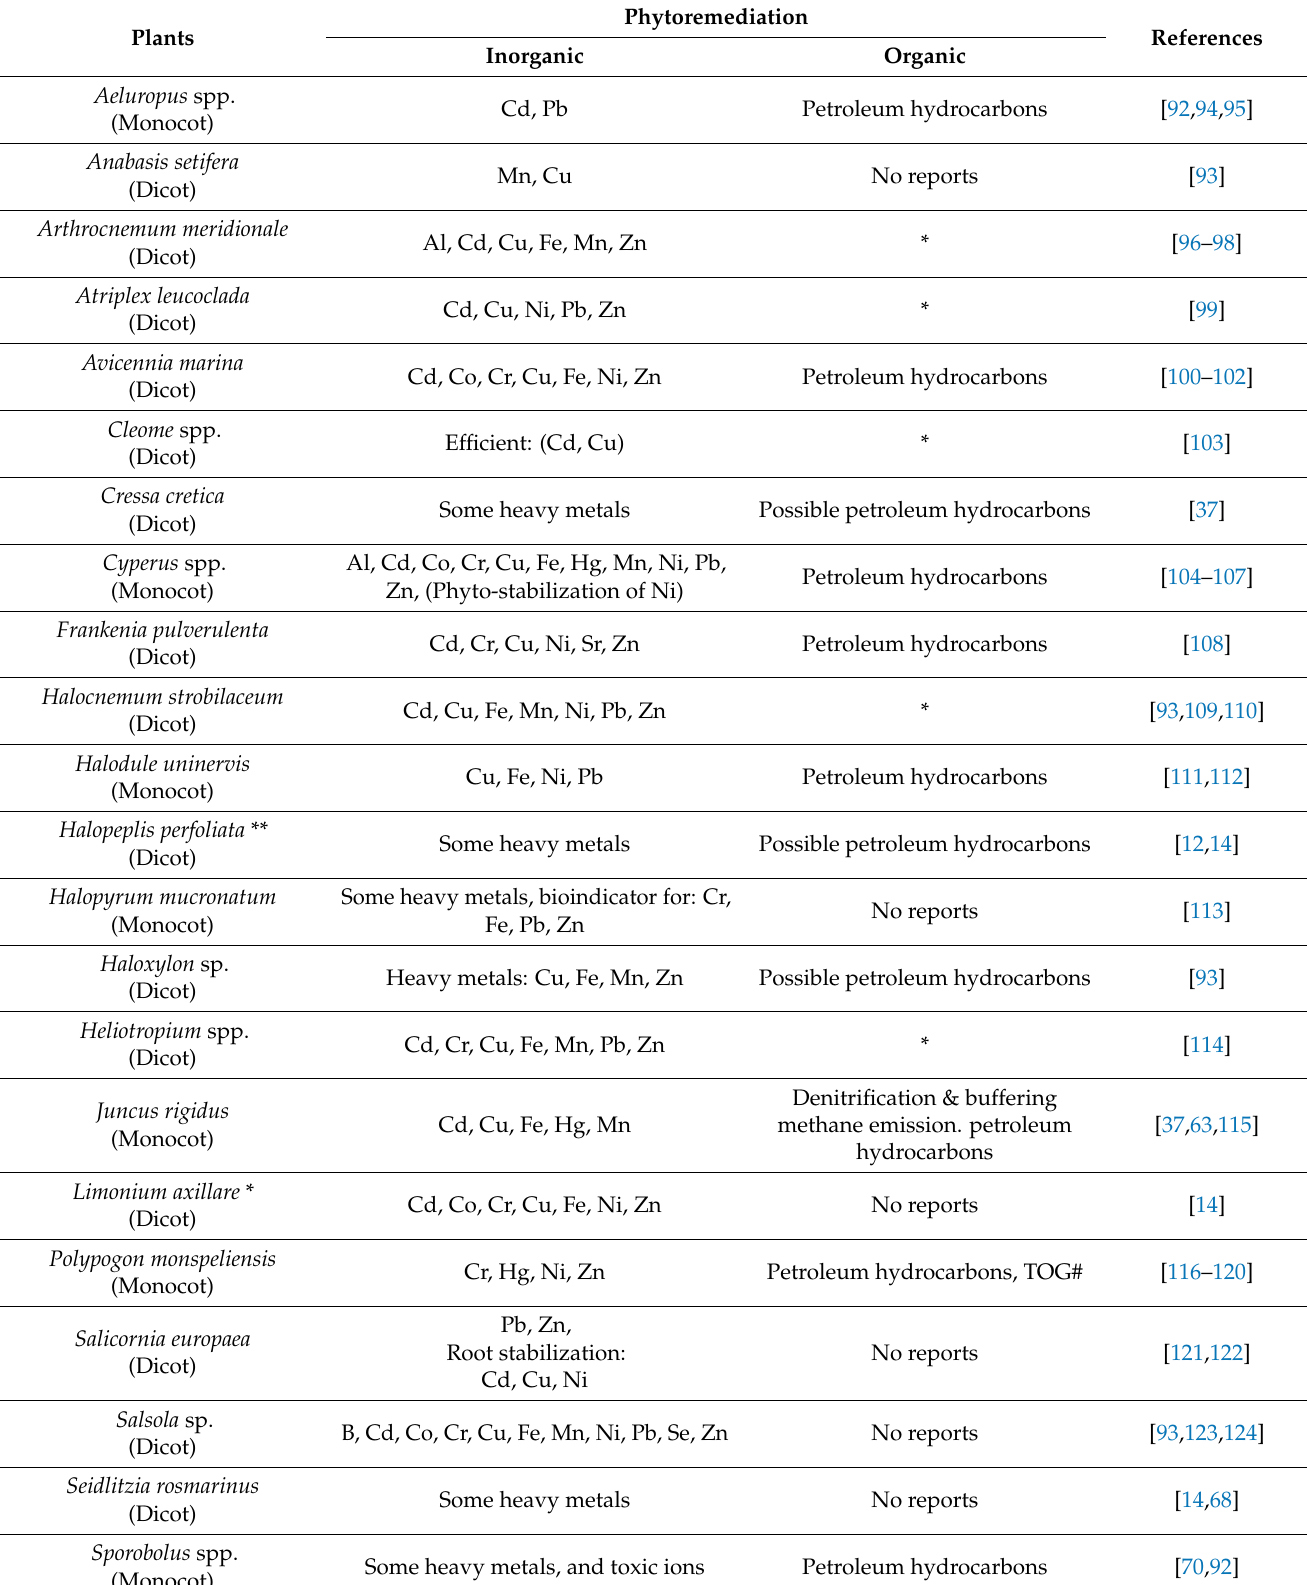
Table 2. Halophyte plants among the flora of Qatar that could be involved in phytoremediation of heavy metals and petroleum hydrocarbon